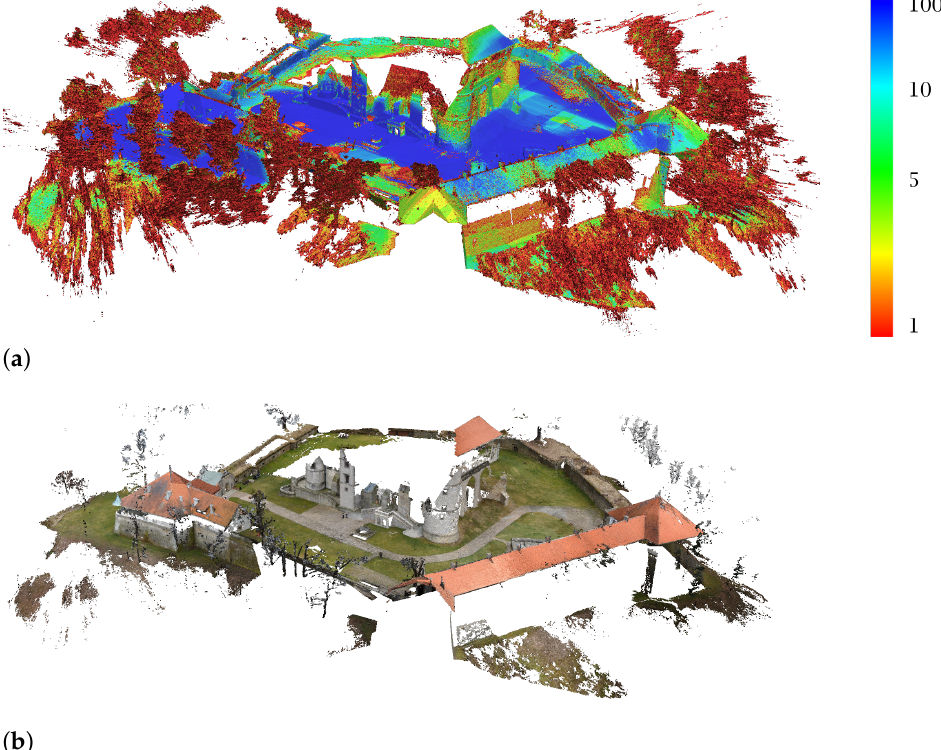
Figure 9. Point cloud confidence ( a ); point cloud after confidence filtration—levels 1–3 removed ( b